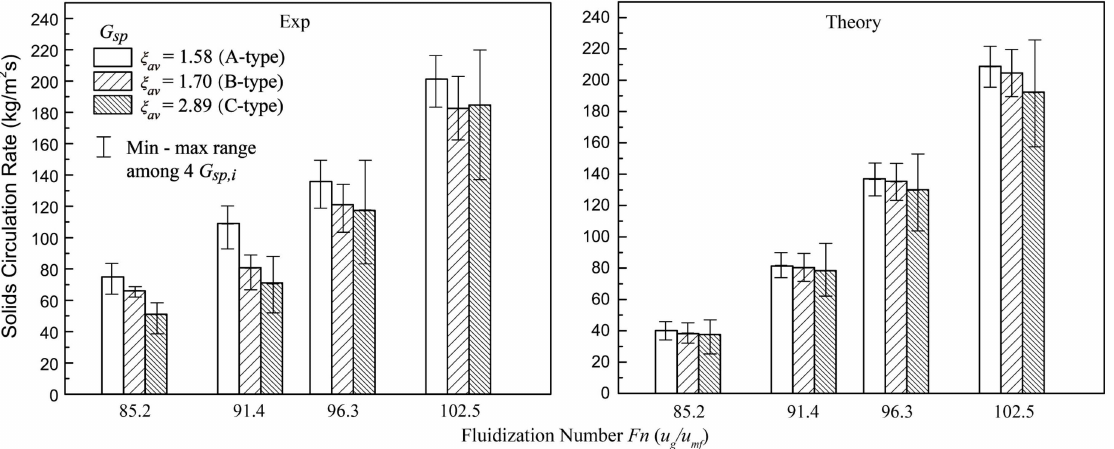
Figure 14. Effect of superficial velocity on solids circulation rate G sp with different ξ av . The effect of superficial velocity on G sp,i in each solids recycle loop from the C-type connection mode is shown in Figure 15. Increasing superficial velocity intensifies solids circulation rate at all recycle loops. However, this enhancement effect varies with different recycle loops (standpipe No.). The recycle loop with larger corresponding ξ b,i (e.g., No. “1”) has slighter changes in circulation rate with superficial velocity. On contrary, the recycle loop No. “4” has the smallest corresponding ξ b,i , and its circulation rate increases most enormously with superficial velocity. The different responding effects for superficial velocity among each standpipe can also explain the phenomenon in Figure 14 that, the non-uniformity among G sp,i is enlarged with growing superficial velocity.